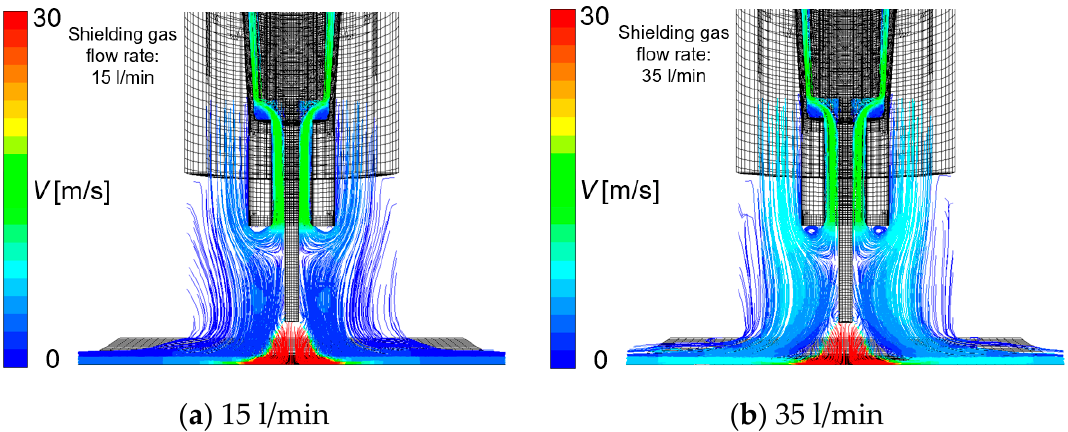
Figure 6. The effect of the shielding gas flow rate on gas flow velocity: ( a ) 15 l/min, ( b ) 35 l/min.